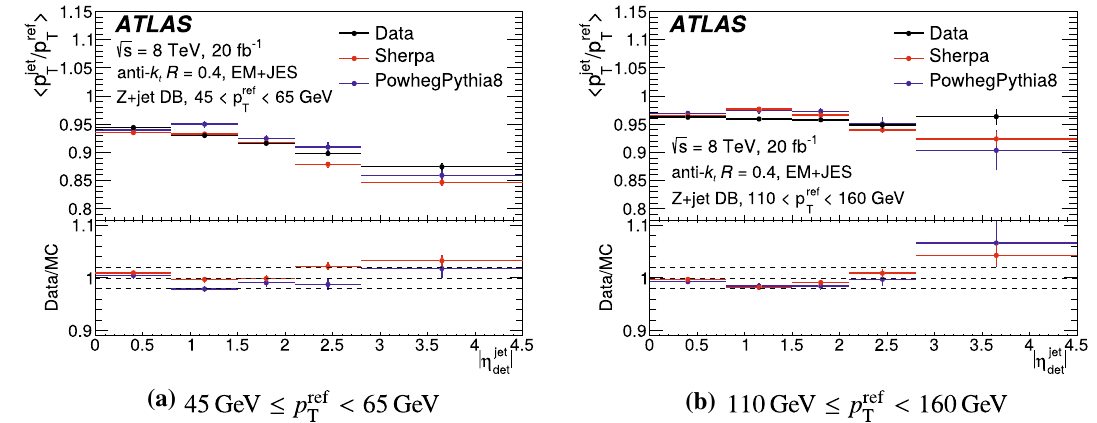
Fig. 23 R DB as a function of η det for anti- k t jets with R = 0 . 4 calibrated with the EM+JES scheme in data (black), as well as in Sherpa (red) and Powheg+Pythia8 (blue) simulation, for a 45GeV ≤ p ref